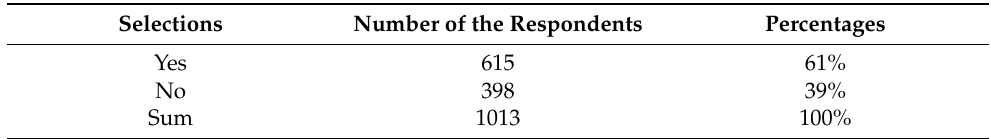
Table A22. Do you think that the legal trade of cryptocurrencies should be firstly permitted to operate and test in China’s Xiamen pilot FTZs (single-choice question)?